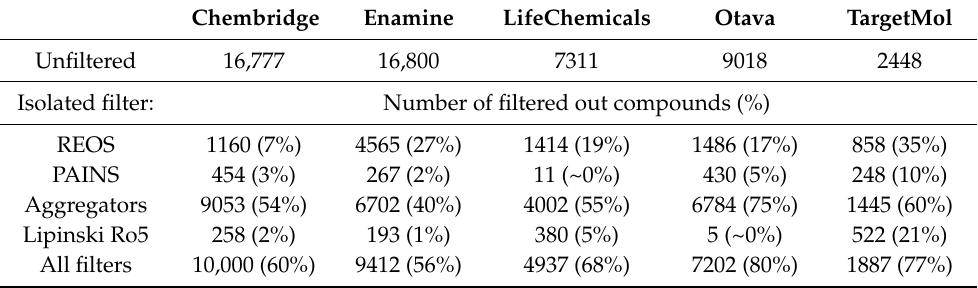
Table 3. Analysis of the attrition rate of various filters for the SARS-CoV-2-targeted